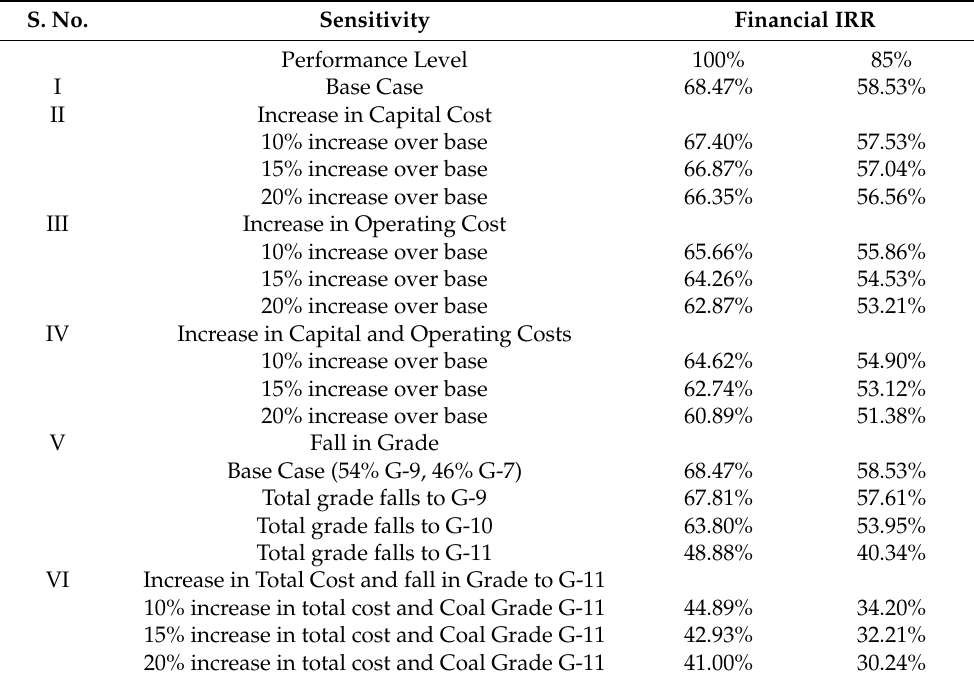
Table 10. Financial IRR of top coal caving at 100% and 85% performance